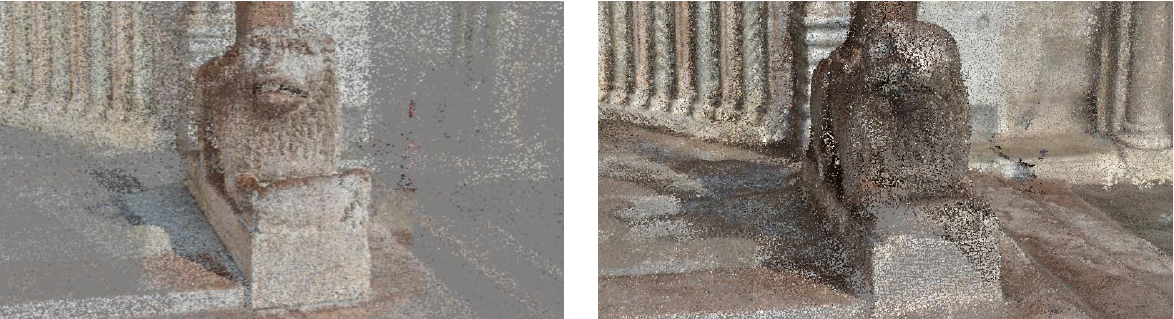
Figure 2: An example of the sparse (left) and dense (right) point cloud produced by jointly processing UAV and terrestrial images featuring different scales, viewpoints, etc. The final dense cloud is noisy and with visible misalignments, due to inaccurate orientation results. • Registration methods based on automated 2D-2D or 3D-3D correspondence extraction: they focus on the development / improvement of new tie point or 3D feature matching